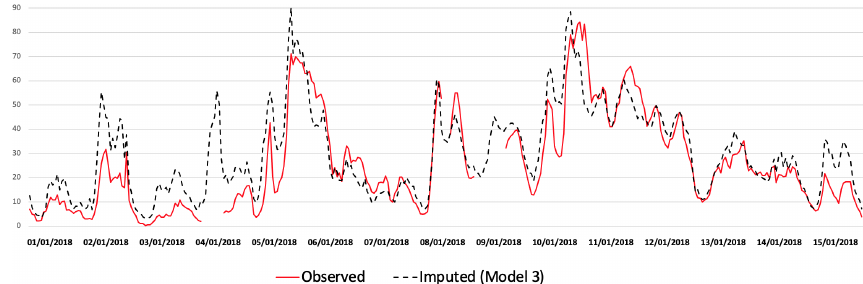
Figure 14. Imputed (black) and real (red) TS comparison for NO 2 at Birmingham Acocks Green station from 1 to 15 January